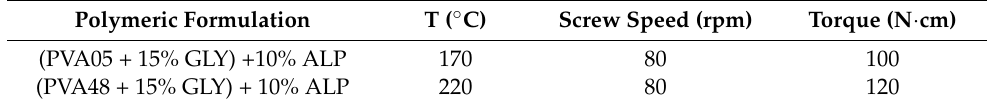
Table 1. HME process